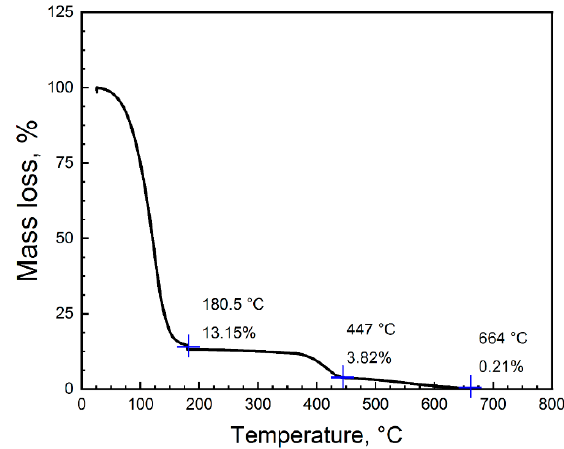
Figure 6. TGA analysis of the binder.